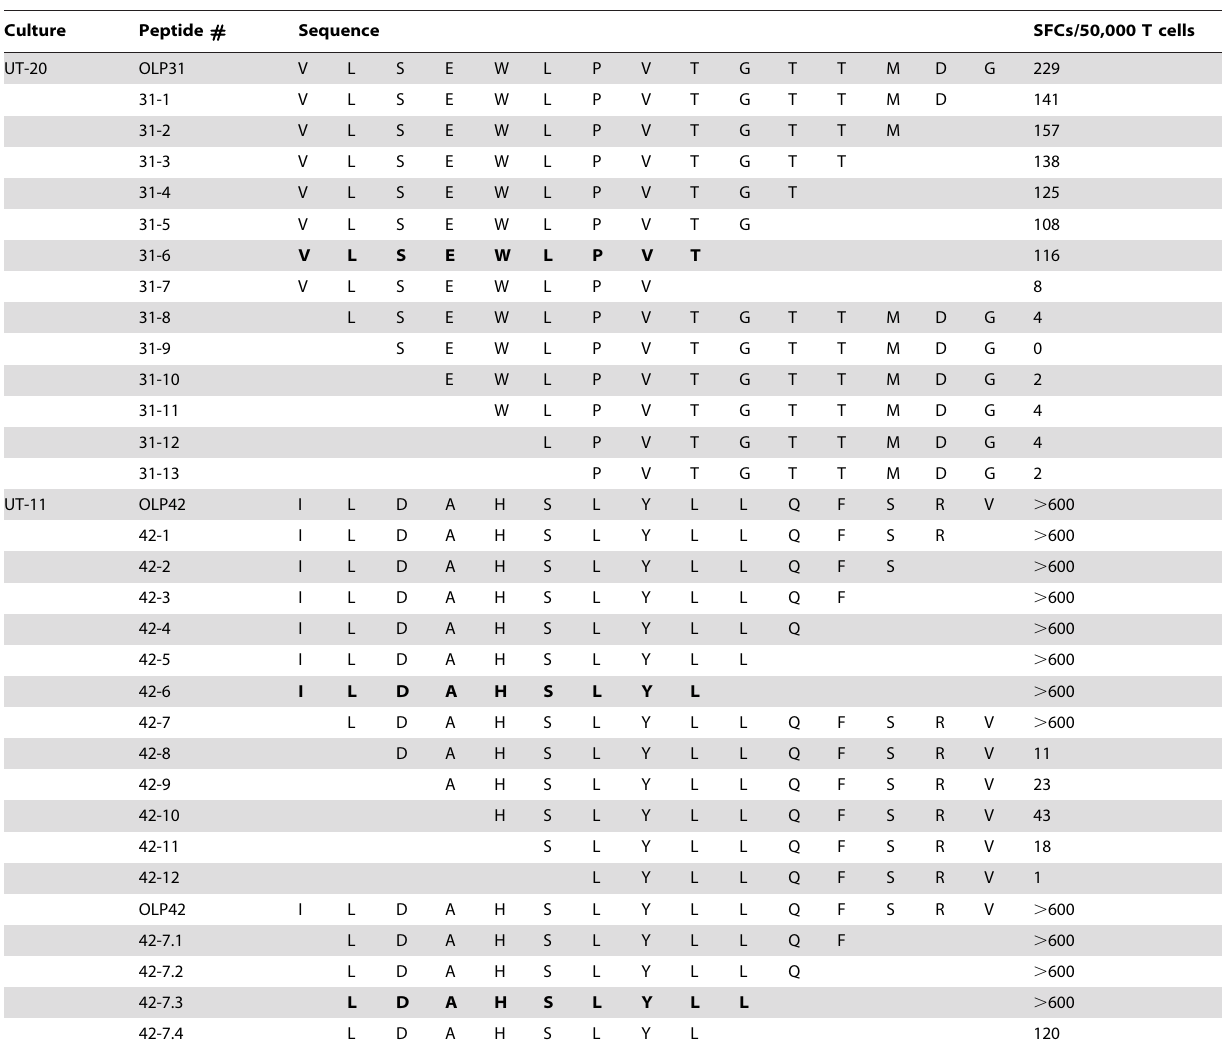
Table 2. Fine mapping of minimal epitopes in OLP31 and OLP42.